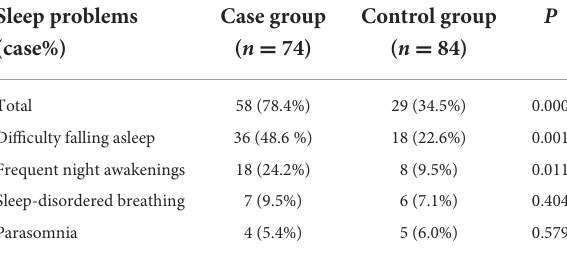
TABLE 2 Comparison of the incidence of sleep problems between the case group and the control